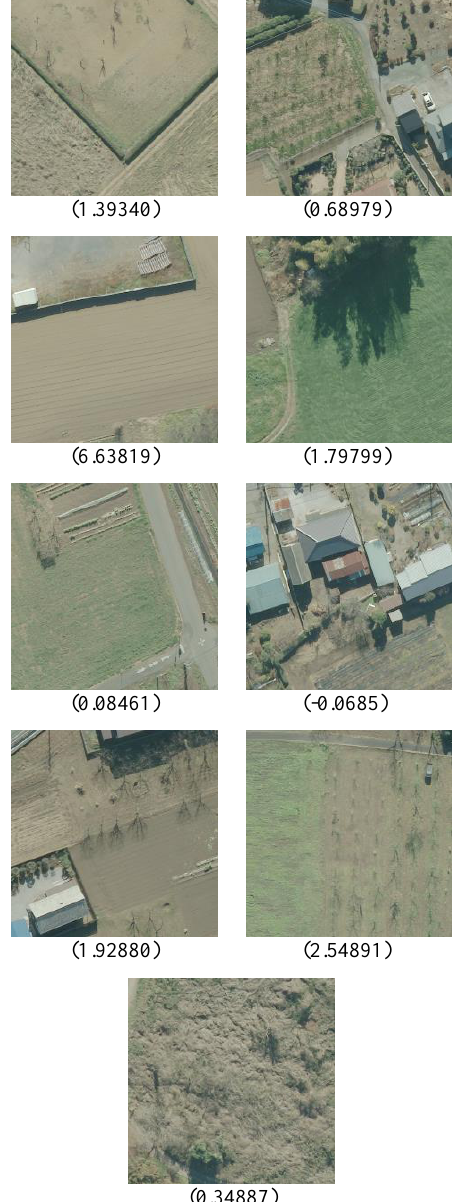
Figure 13. Cropped photographs with high evaluation